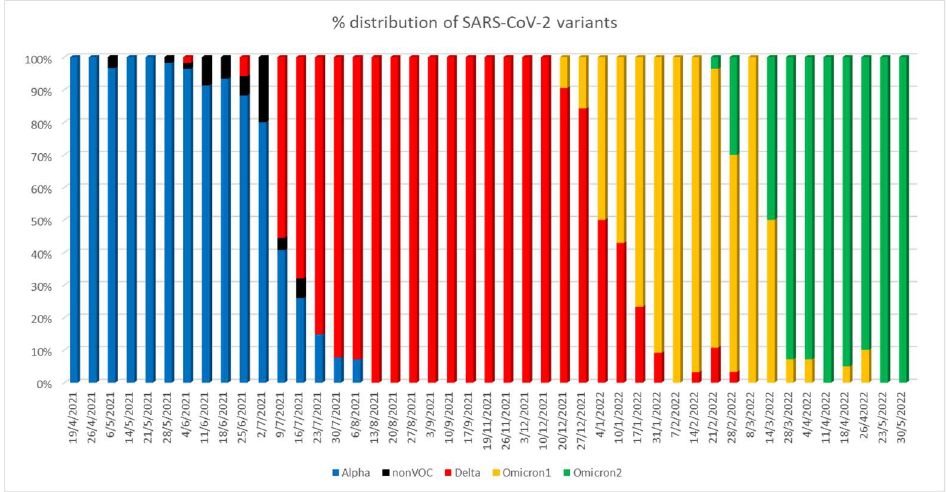
Figure 4. % distribution of SARS-CoV-2 variants detected in the hospital setting during the study period; nonVOC: non-variant of concern.